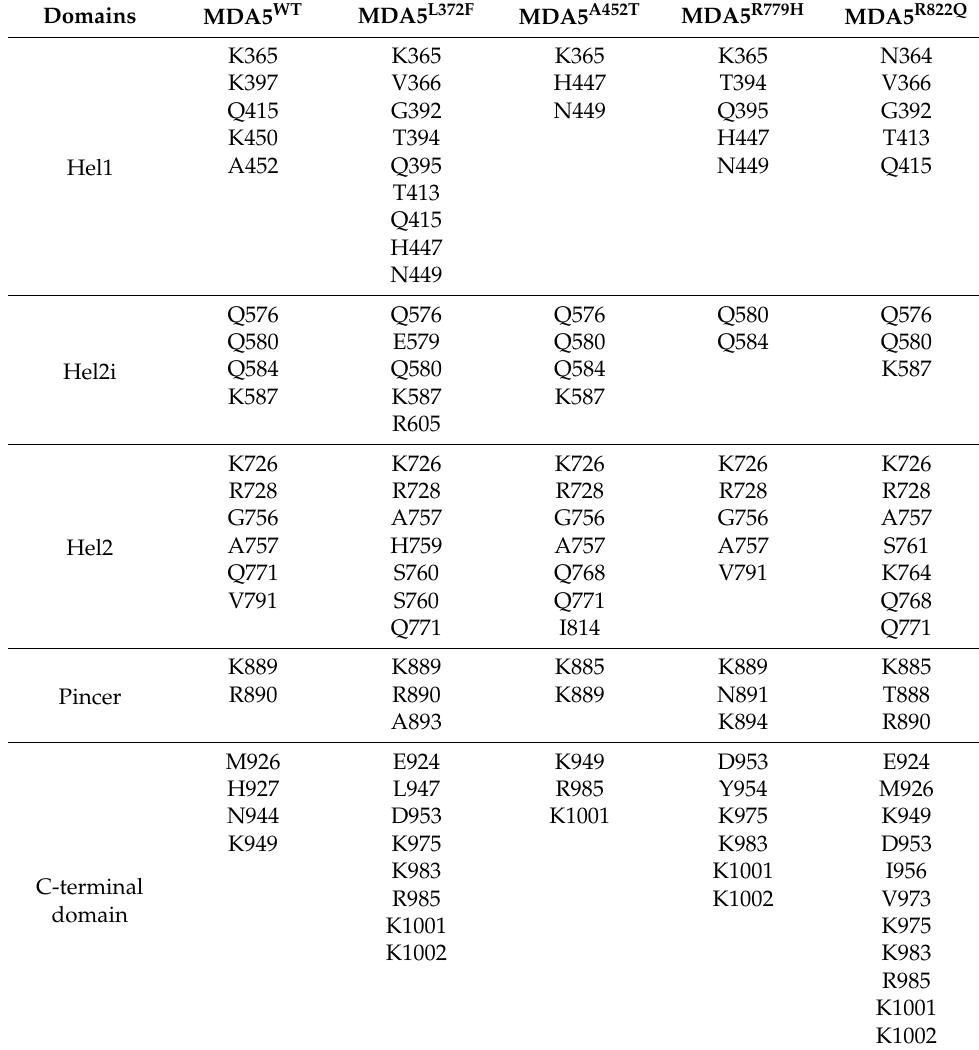
Table 2. Hydrogen bond interactions between dsRNA and